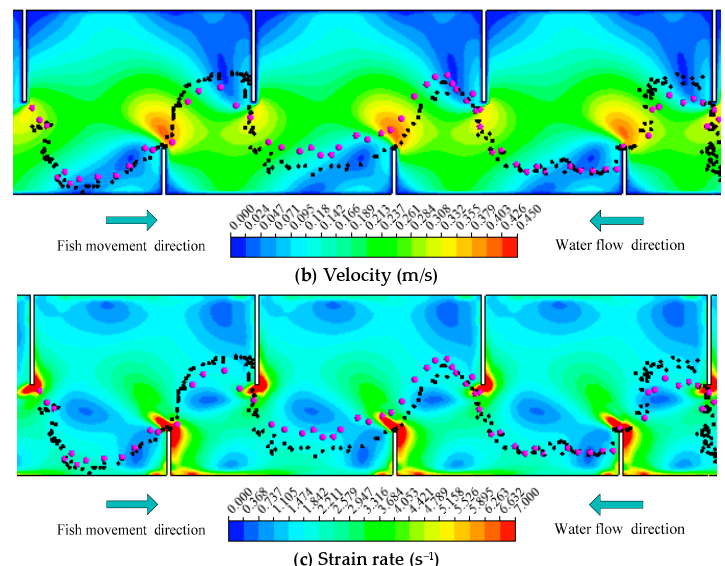
Figure 8. Representative trajectory of Fish C combined with ( a ) TKE; ( b ) V; ( c ) SR distribution in Pools 2–4 (Notes: The rose red points represent the simulated fish movement trajectories, and the black points represent the measured trajectories of fish).